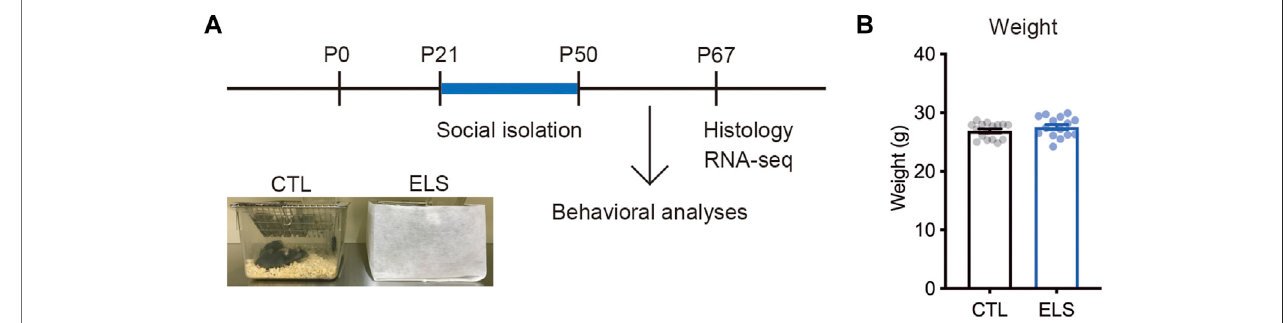
FIGURE 1 | Experimental scheme. (A) Experimental design and time course of early life stress (ELS). In ELS mice, male mice were individually housed after the weaningatpostnataldays21(P21)untilP50.Incontrolmice,4malemicewereco-housedinthesamecageaftertheweaningatP21.Mousebehaviors,brain,andgene expression were analyzed at P50 and P67, respectively. (B) No signi fi cant difference in the weight after social isolation. Data are presented as means ( ± SEM), unpaired t -test, n (cid:2) 15 – 16/condition. CTL, control mice; ELS, early life stressed